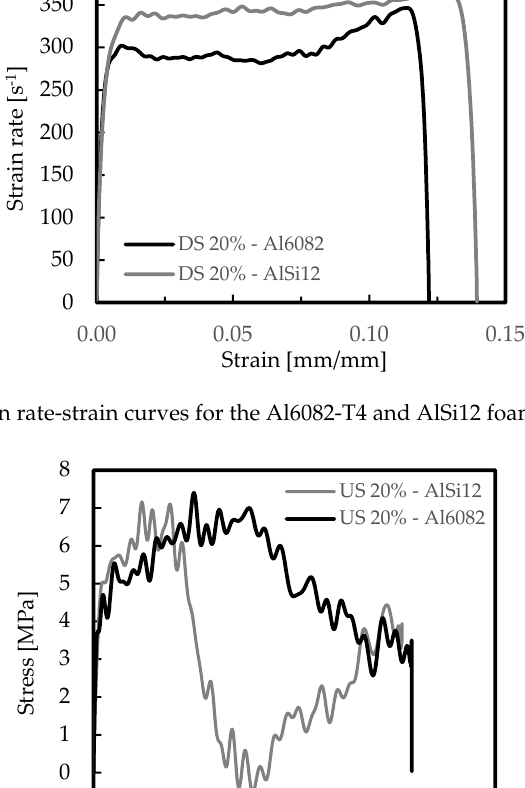
Table 4. Results for the AlSi12 and Al6082-T4 foams US and DS with a relative density of 20%.